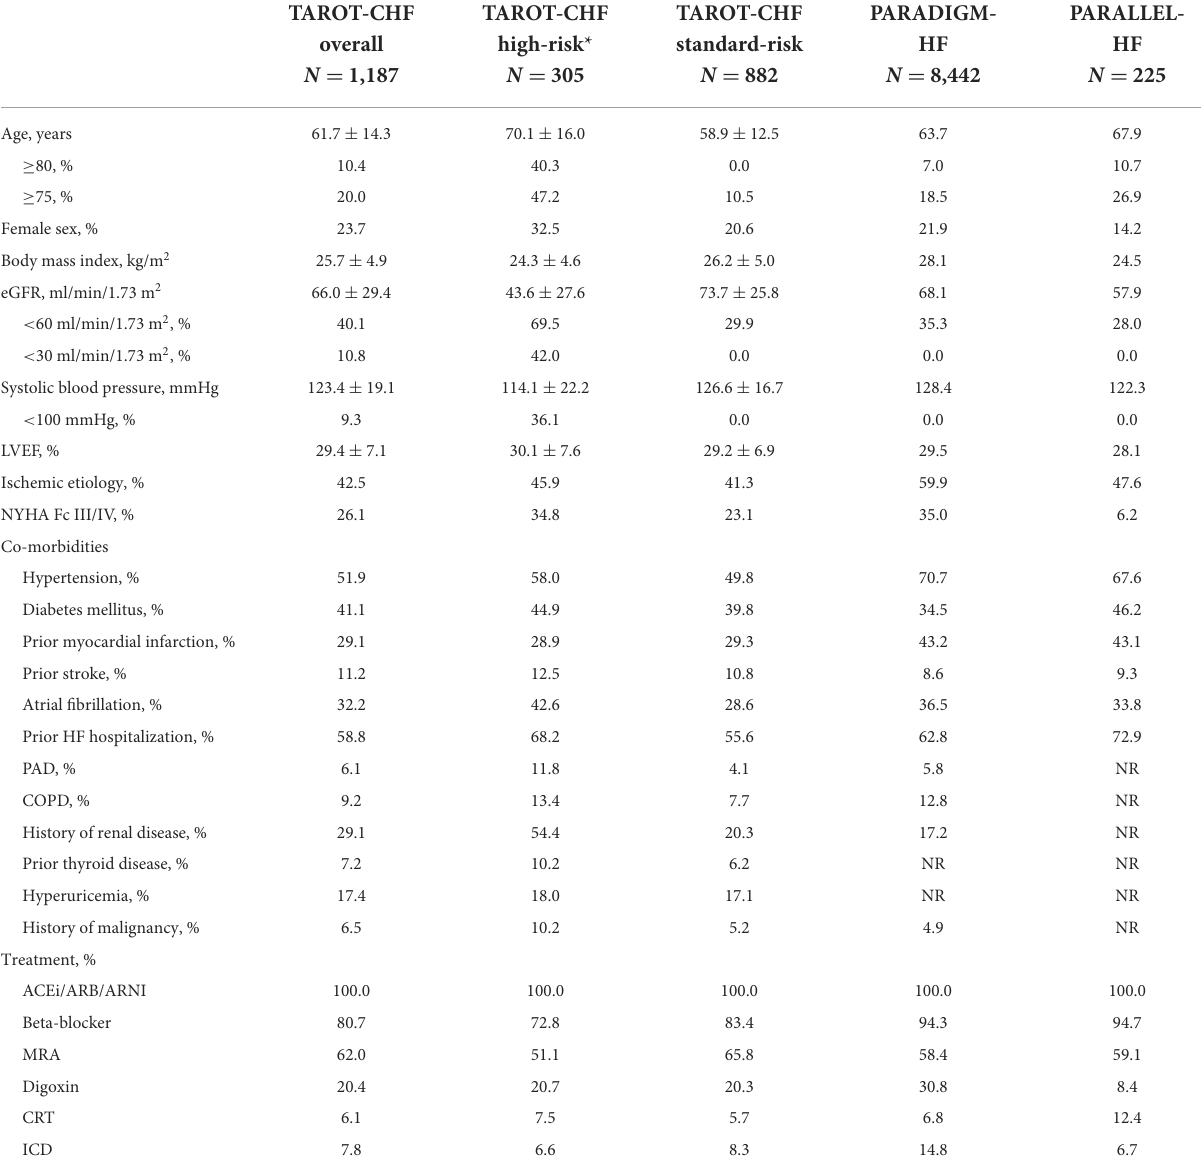
TABLE 1 Demographics, clinical characteristics and treatment of the current study and clinical trials of sacubitril/valsartan.